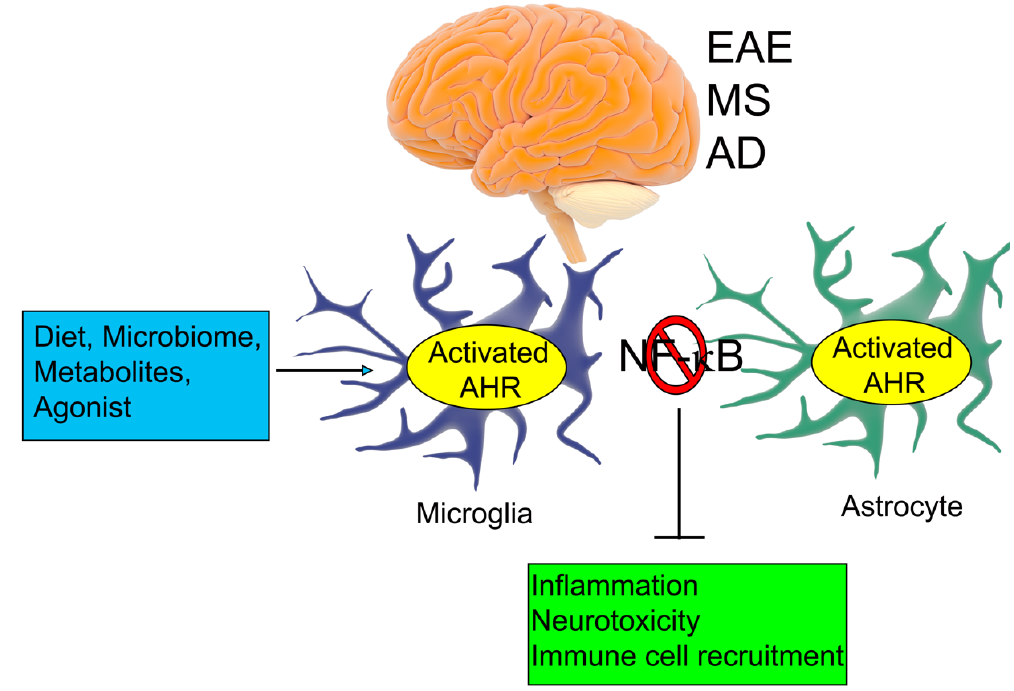
Figure 2. The AHR and neurodegeneration. AHR signaling is involved in the regulation of inflammation, neurotoxicity, and immune cell recruitment in various neurodegenerative diseases. The AHR regulates disease pathology via microglia and astrocytes in CNS. AHR agonists (endogenous and pharmacological) have been shown to inhibit NF- κ B-mediated inflammatory signaling. EAE: experimental autoimmune encephalomyelitis; MS: multiple sclerosis; AD: Alzheimer’s disease.